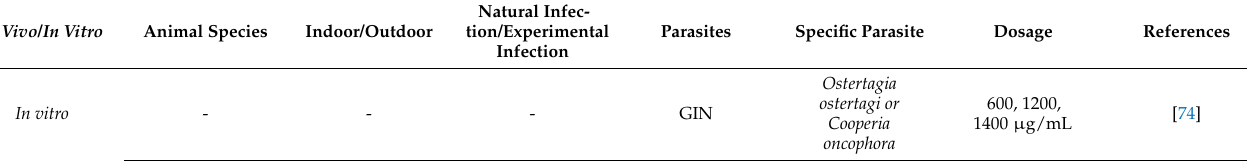
Table 7. Brief description of trials for the antiparasitic plant: Lotus